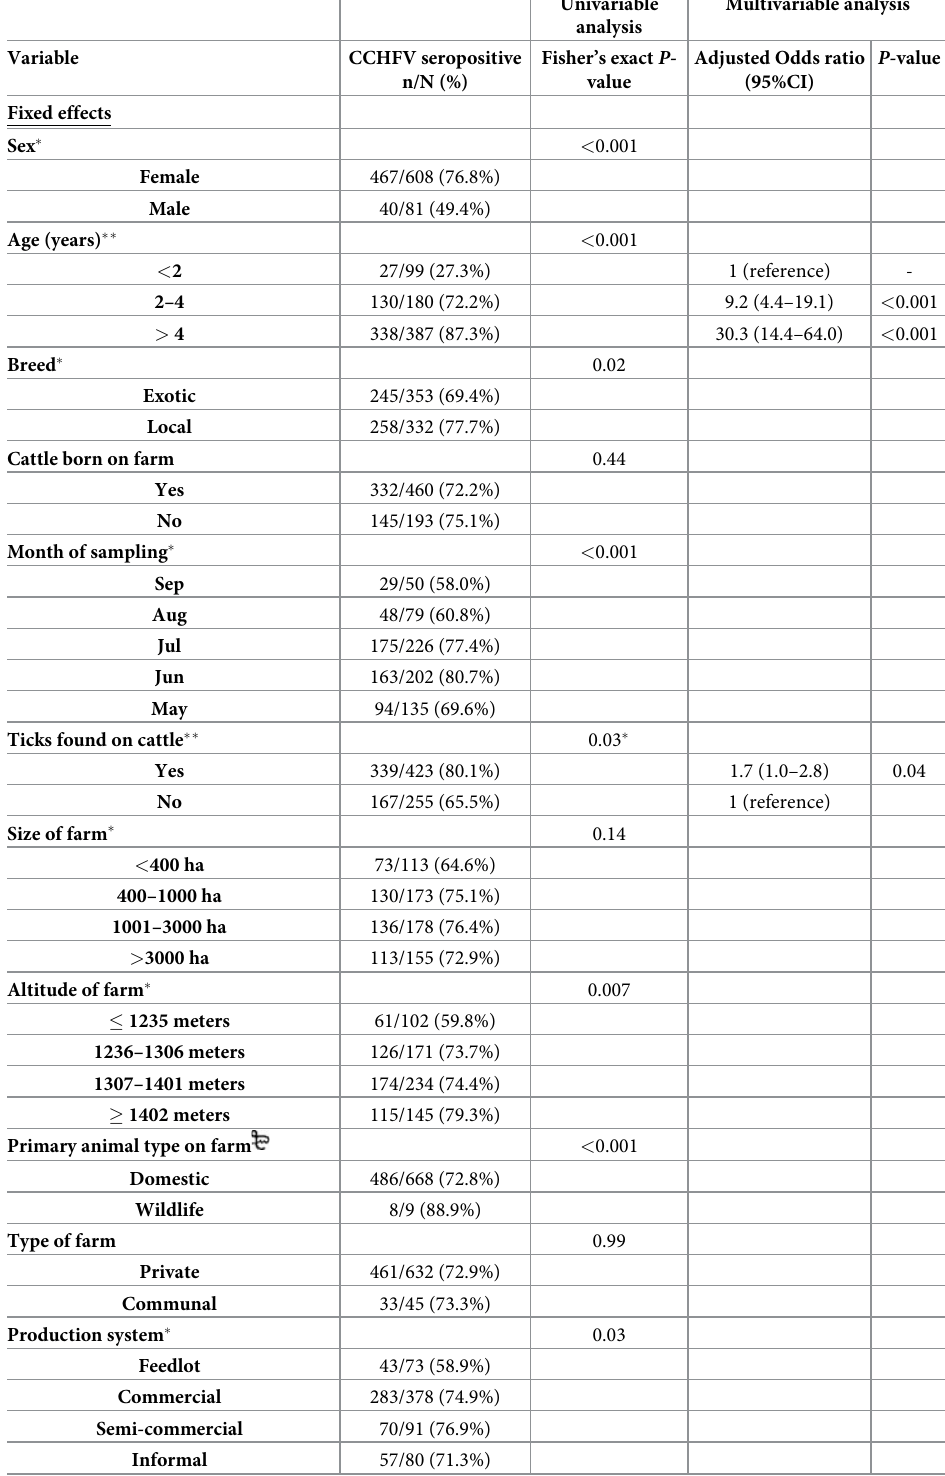
Table 4. Univariable analysis and multivariable model of exposure factors associated with Crimean-Congo hae- morrhagic fever virus seroprevalence in cattle in central South Africa, 2017 (S2